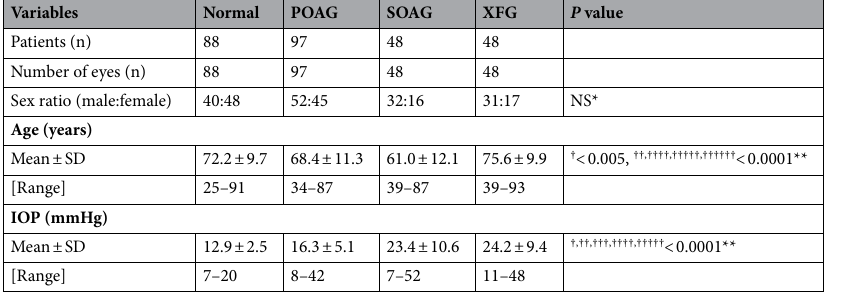
in AH were correlated significantly with each other 10 . Therefore, we speculate that crosstalk may exist between ATX and TGF-βs, suggesting that concurrent levels of these mediators may be promising diagnostic biomarkers. To our knowledge, this is the first study to investigate the correlation between ATX and TGF-βs in differentiat-